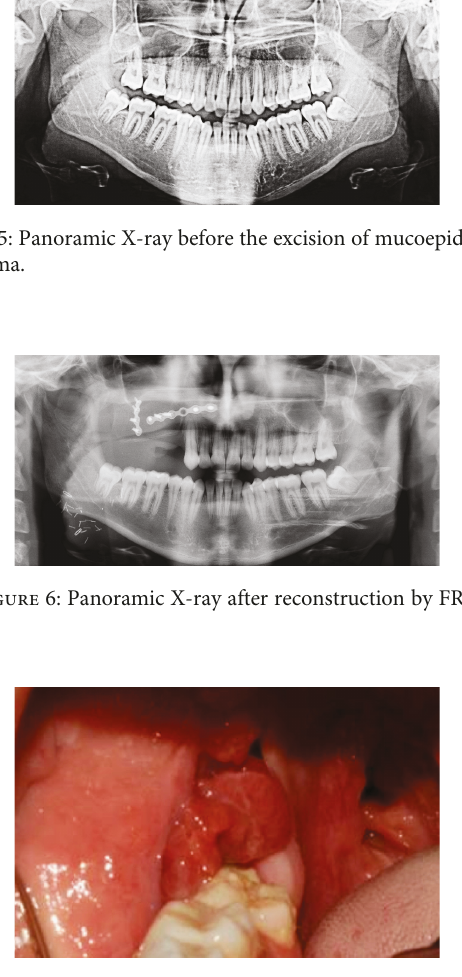
Figure 7: Clinical preoperative.